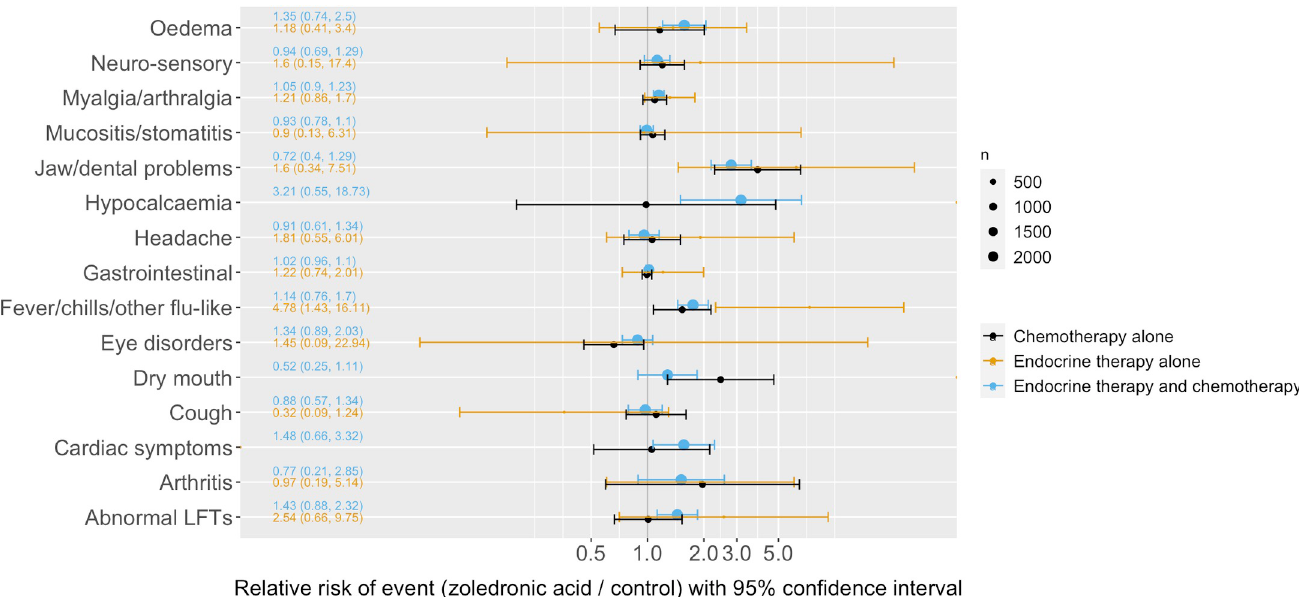
Fig 4. Analysis of individual patient data in AZURE by concurrent treatment regime. The relative risk of each side-effect for patients on different treatment regimes is shown alongside bisphosphonates.